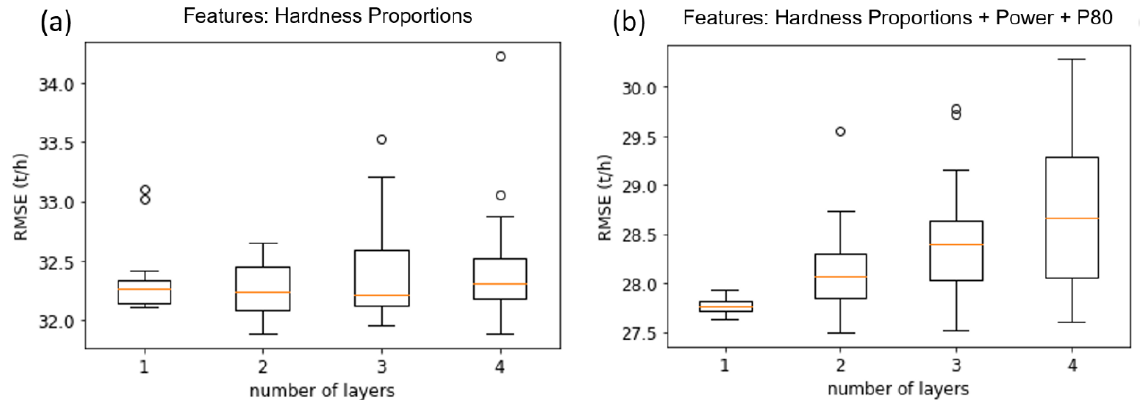
Figure 4. Comparison of the number of hidden layers for two selected feature sets: ( a ) hardness proportions and ( b ) hardness proportions, ball mill power and product particle size (P80).